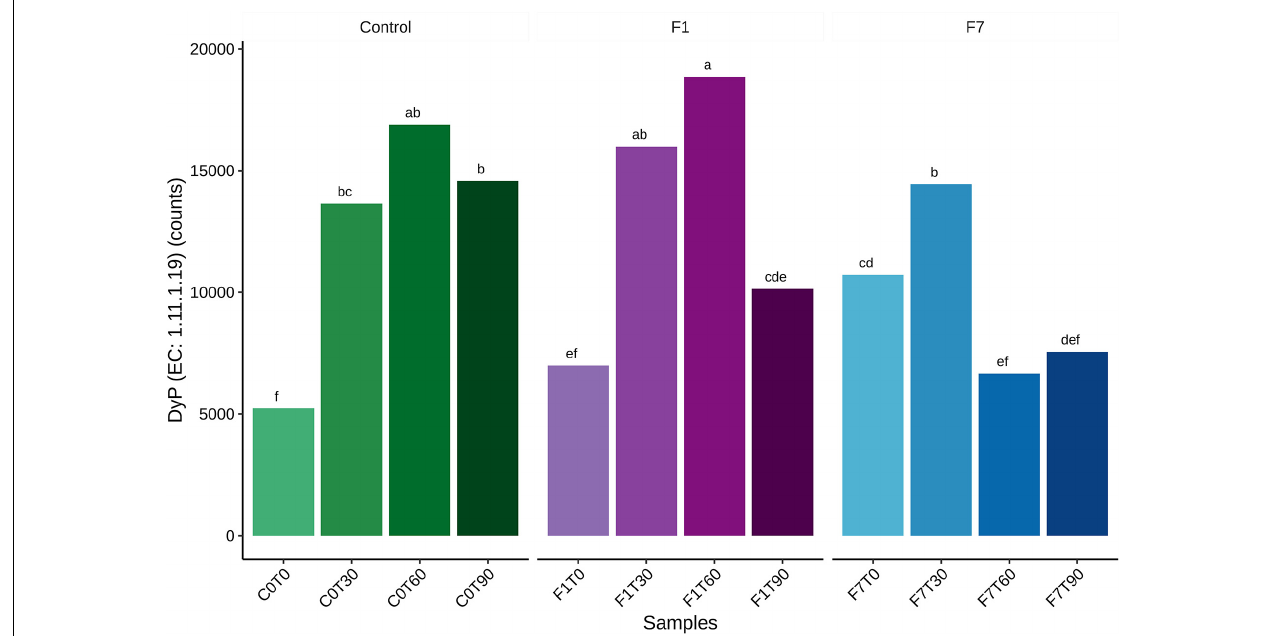
FIGURE 12 | Average of total bacterial contributions to dye decolorizing peroxidase (DyP) for each datapoint triplicate. Statistical significance was assessed by Friedman test followed by Fisher LSD post-hoc test with Benjamini–Hochberg FDR corrected for multiple comparisons. Group labels represent statistical significance at α = 0.05. Groups sharing one or more letters are not significantly dissimilar.